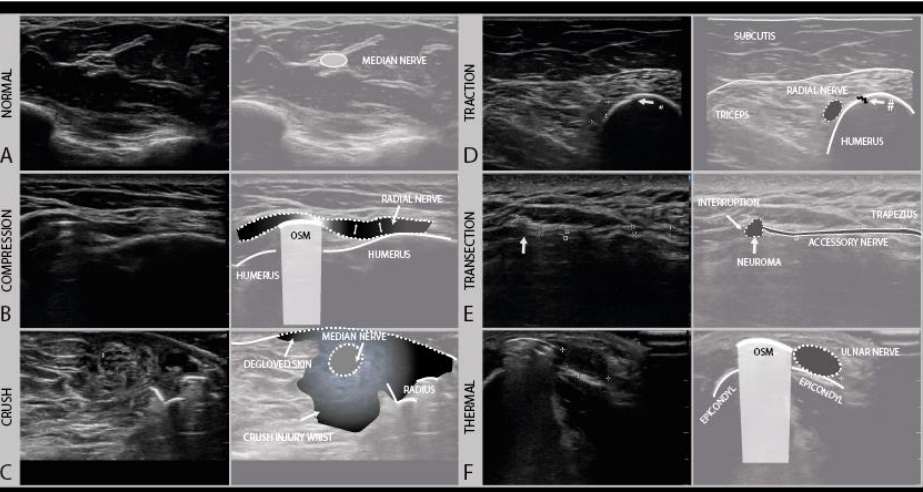
Figure 7. Examples of different trauma types. The normal transverse aspect of a median nerve in the forearm ( A ). Local compression injury of the radial nerve by local osteosynthesis material (OSM). Focal enlargement of the nerve diameter proximal to the lesion site can be seen ( B ). Crush injury of the median nerve at the level of the forearm with surrounding crushed subcutaneous tissue and degloved skin ( C ). Traction injury of the radial nerve after humeral fracture (#). Swollen and hypoechoic aspect of the radial nerve ( D ). Iatrogenic transection injury of the accessory nerve after resection of a local lipoma. A stump neuroma can be seen at the site of nerve injury, with a loss of continuity. ( E ). Swollen and hypoechoic ulnar nerve after thermal injury (hot K-wire) at the level of the medial epicondyle with in situ osteosynthesis material ( F ).